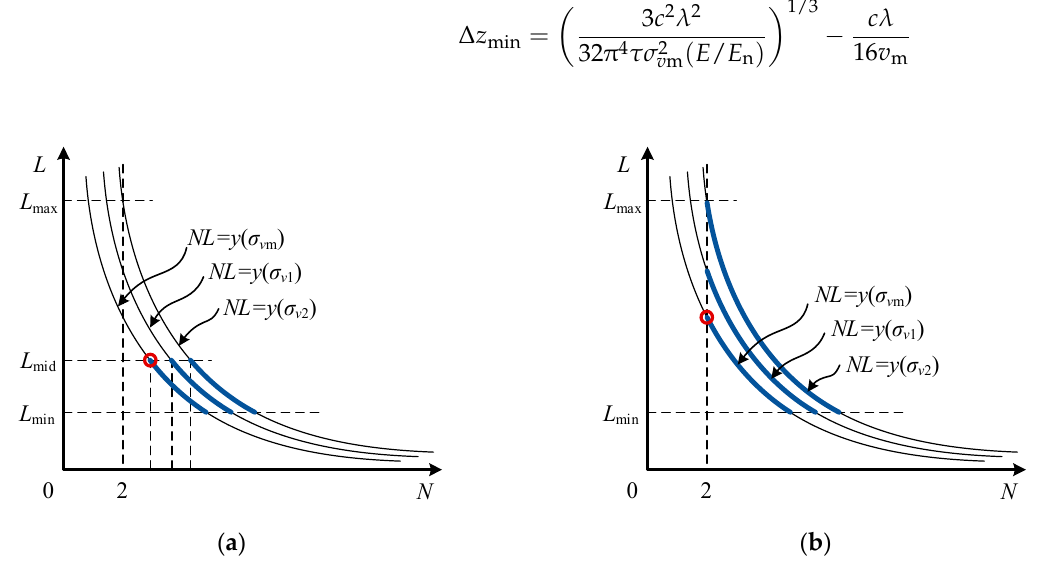
Figure 6. Feasible region of cost function of water stratification accuracy: ( a ) the case of y ( σ v m ) ≥ 2 L mid ; ( b ) the case of y ( σ v m ) < 2 L mid .